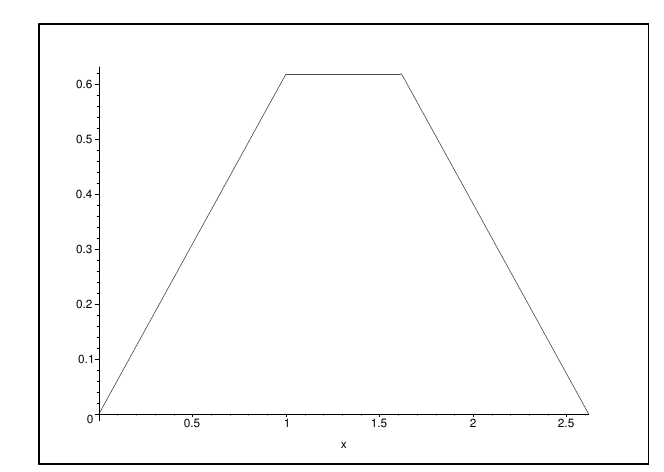
Figure 4 – The graph of f